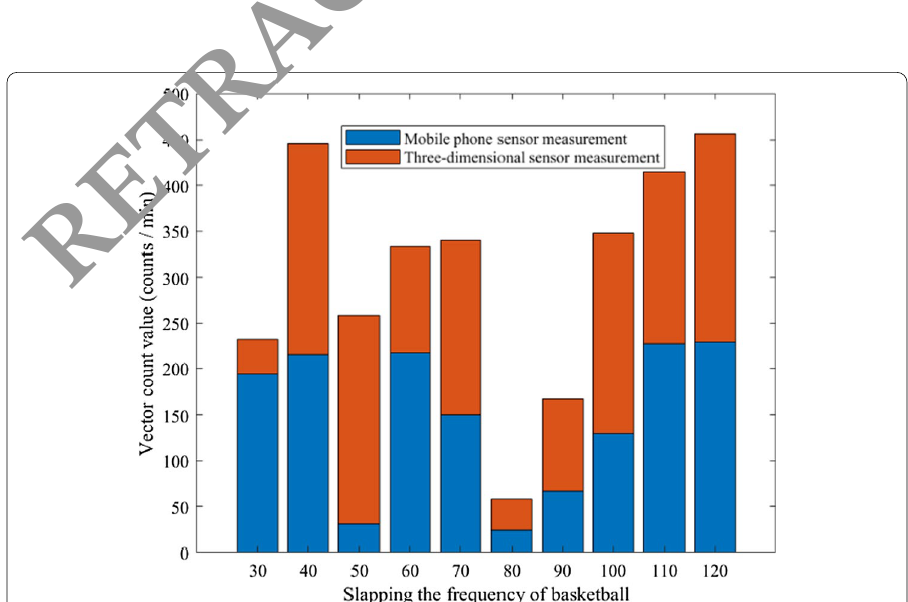
Fig. 6 Comparative analysis of different acceleration sensor vectors on the frequency of basketball